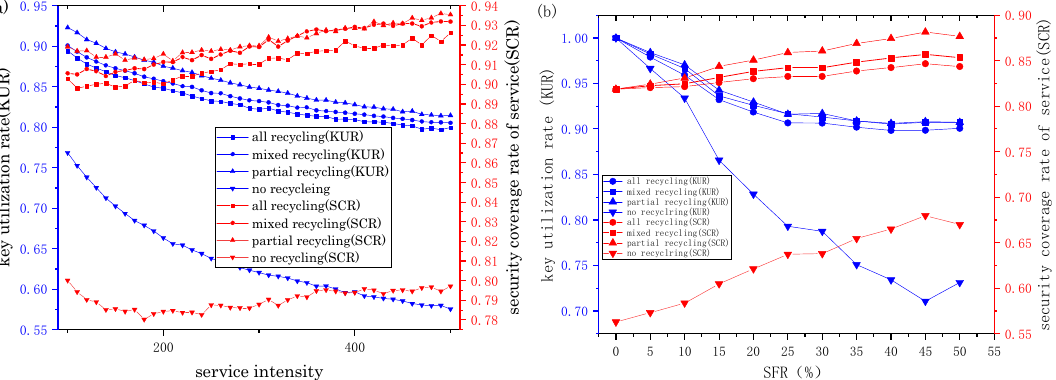
Figure 10. ( a ) The impact of service intensity on key utilization rate (KUR) and security coverage rate of service (SCR) of QKD networks with different QKR mechanisms and traditional QKD networks, when V key_gen is 120 and service failure rate (SFR) is 30%.; ( b ) The impact of SFR on KUR and SCR of QKD networks with different QKR mechanisms and traditional QKD networks, when V key_gen is 120.